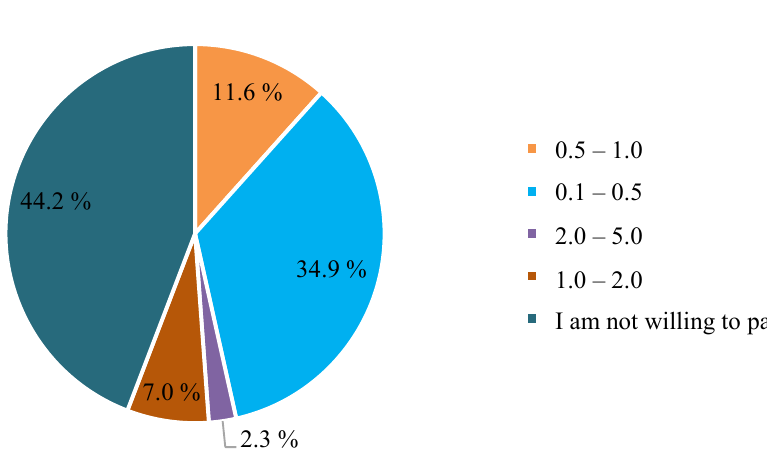
Fig. 6. Willingness to pay for use of installed FGTE, EUR/m 2 (considering area of the